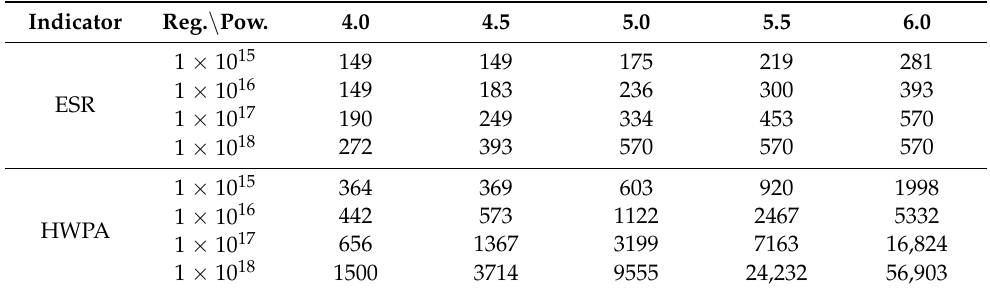
Table 5. Filtering strength metrics of the kernel with different regularization coefficients and different power indices of SCM: equivalent smoothing radius (ESR) and half-weight polygon area (HWPA). The unit of HWPA is thousands of square kilometers, whereas that of ESR is kilometers. Indicator Reg. \ Pow.